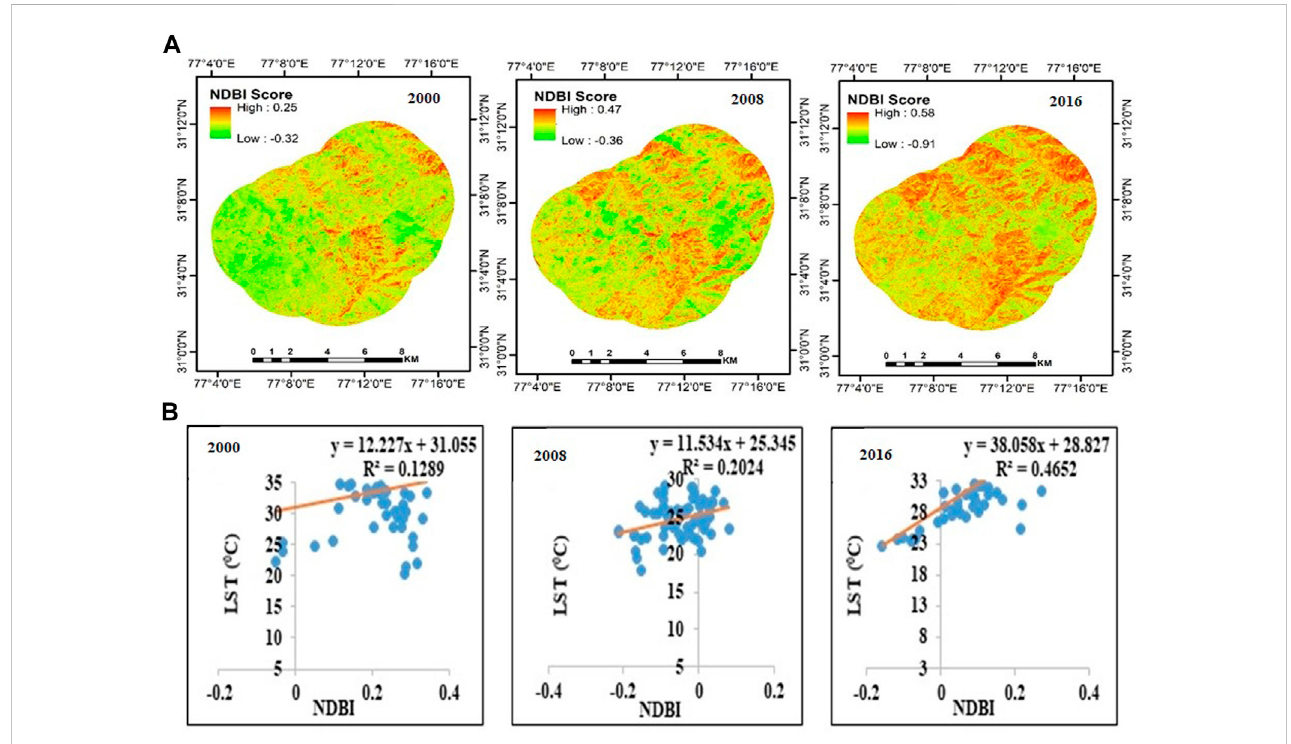
FIGURE 5 Change in NDBI (A) and degree of association of NDBI with LST (B) for Shimla.